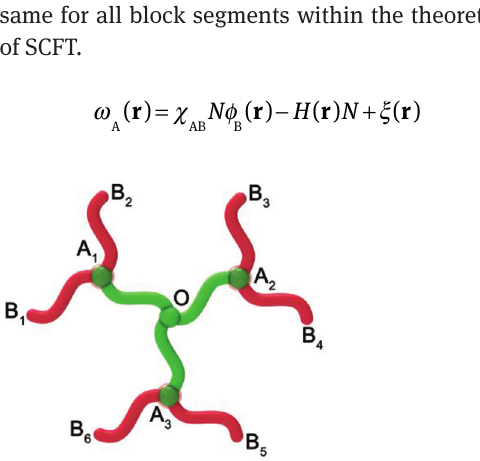
Figure 1: Molecular architecture of a dendrimer copolymer, in which block A (green) and block B (red) represents the first and the second generation of the dendrimer copolymer,